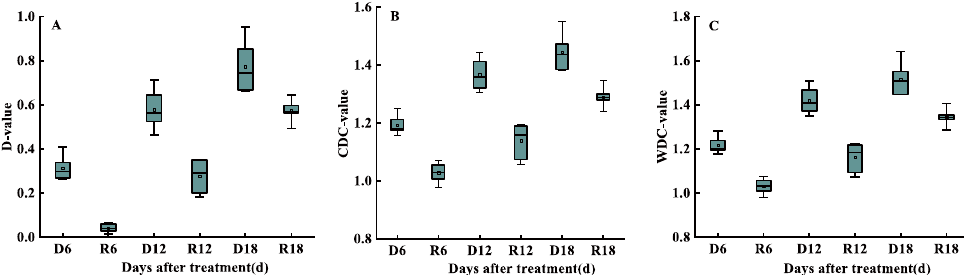
Figure 6. Changes in the comprehensive evaluation values of drought tolerance. ( A ) Drought tolerance comprehensive evaluation (D); ( B ) comprehensive drought tolerance coefficient (CDC); and ( C ) weight drought tolerance coefficients (WDC) under drought re-watering conditions. D, drought; R, re − watering. Table 4. Correlation degree between the DC value of all the indices and the D value, together with the WDC value and the weights of their indices.